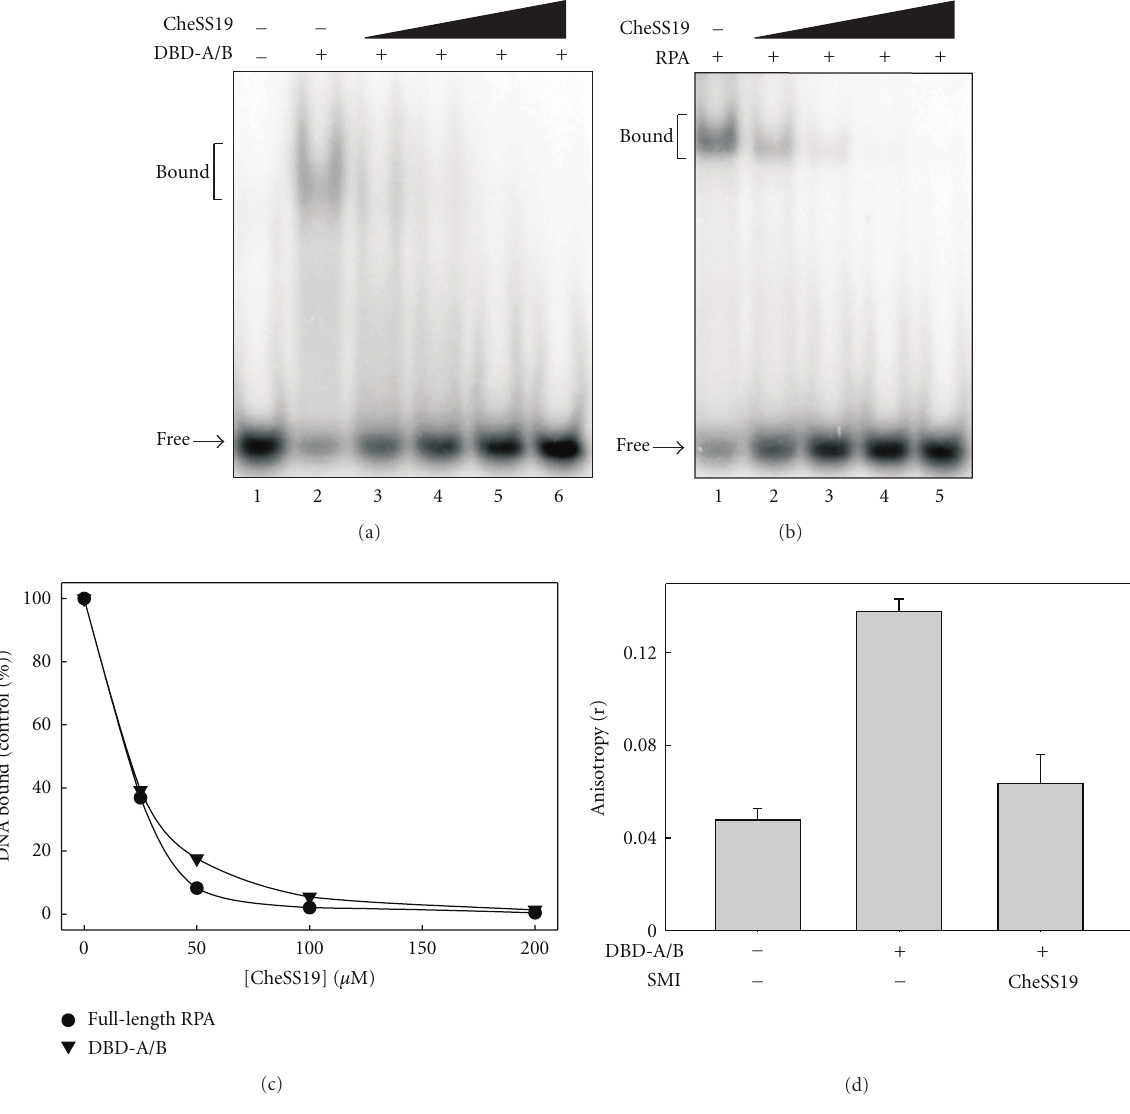
Figure 3: Irreversible inhibition of RPA DBD-A/B-DNA-binding activity by CheSS19. (a) EMSA analysis of CheSS19 inhibition of RPA DBD-A/B. Assays were performed as described in the legend to Figure 2. Reactions contained 12.5mM DNA, 50nM DBD-A/B and 0, 25, 50, 100 and 200 μ M CheSS19 (Lanes, 2-6, resp.) (b) CheSS19 inhibition of full-length heterotrimeric RPA as assessed by EMSA.